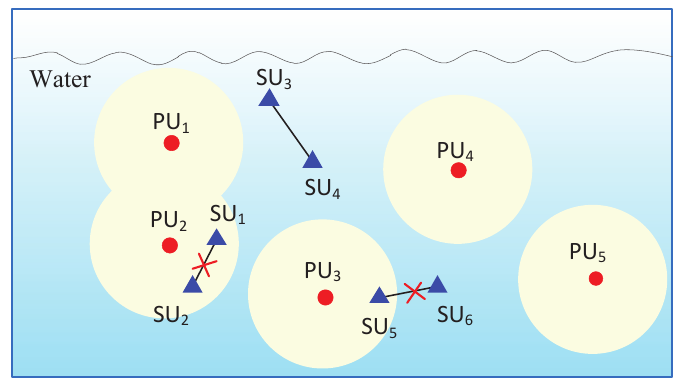
Figure 1. Underwater network model. PU: primary user; SU: secondary